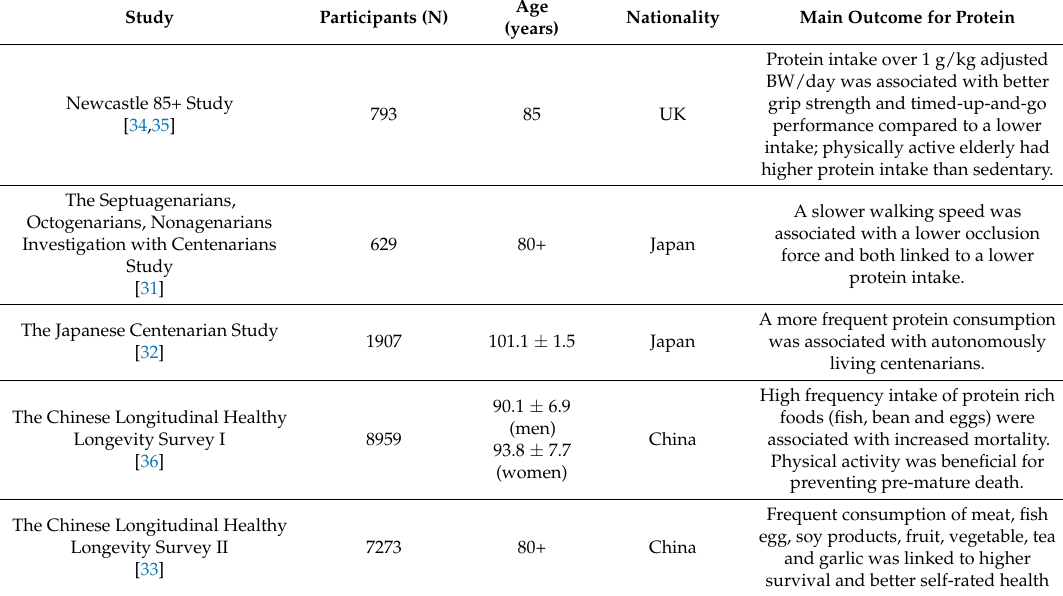
Table 1. Available studies on the oldest old with extracted results linking dietary protein intake with physical function and health